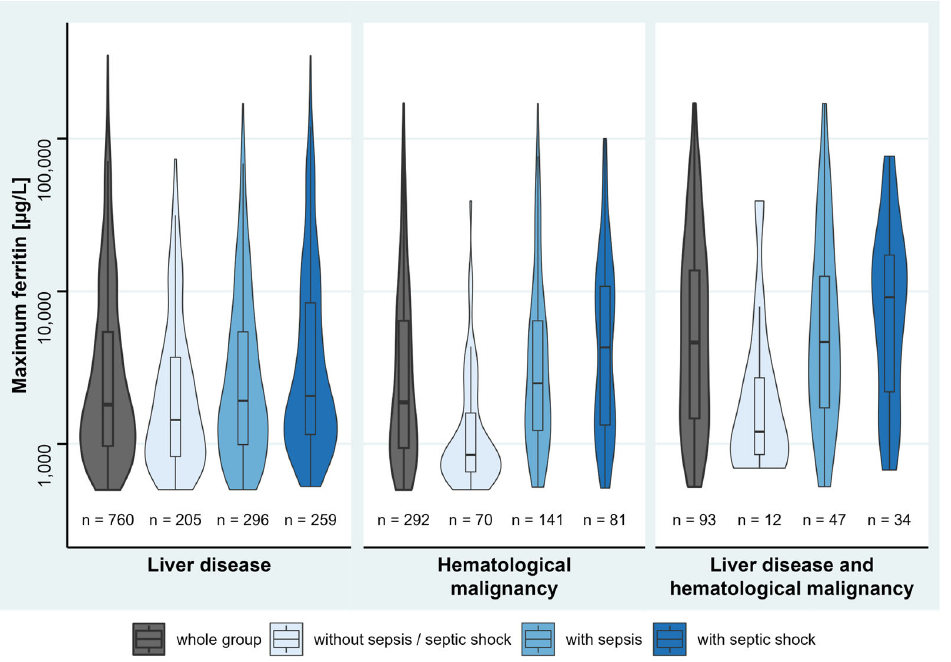
Figure 2. Ferritin levels of positively associated disease groups (each and in combination) on maximum ferritin, stratified by sepsis status. Violin plots show data distribution and enclosed boxplots show median with quartiles (25–75 %). Whiskers below and above show minimum and maximum values, respectively. For improved visualization, y ‐ axis is plotted in logarithmic scale. Due to various numbers of ICD ‐ 10 codes in each single patient, patients partially overlap between the disease groups.